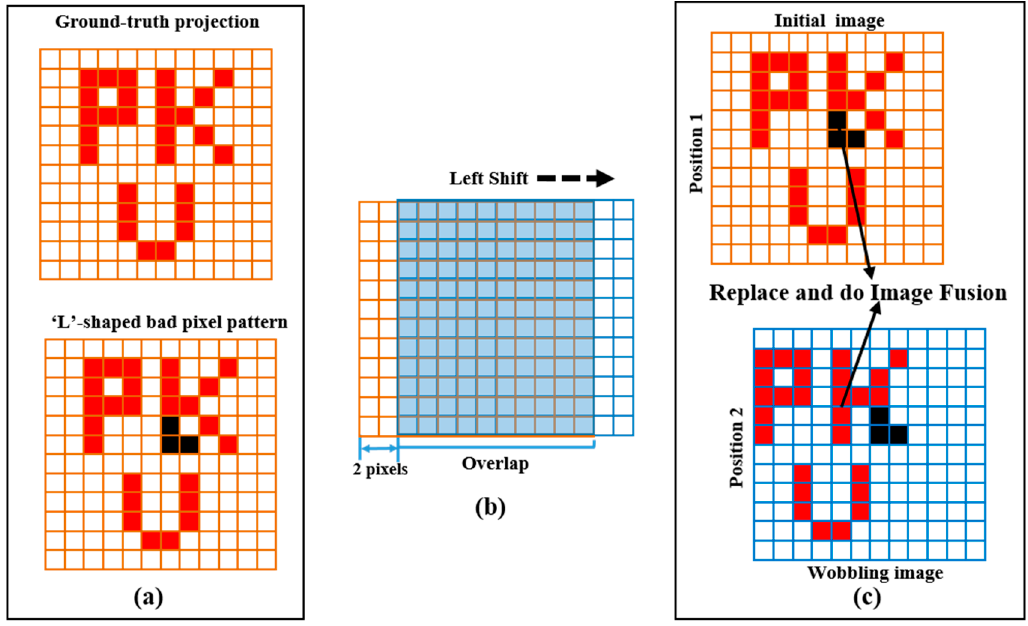
Figure 2. Description of the method for the wobbling technique. ( a ) Example of image without defectives and “L”-shaped bad-pixel pattern in detector; ( b ) The sketch of wobbling acquisition with Left shift; ( c ) Two images of different positions for the same object (Black points represent defective pixels in the fixed position of detector).